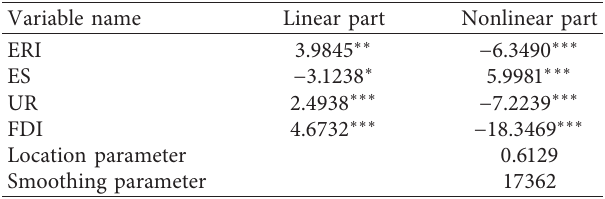
Table 4: Parameter estimation results of panel smoothing threshold regression